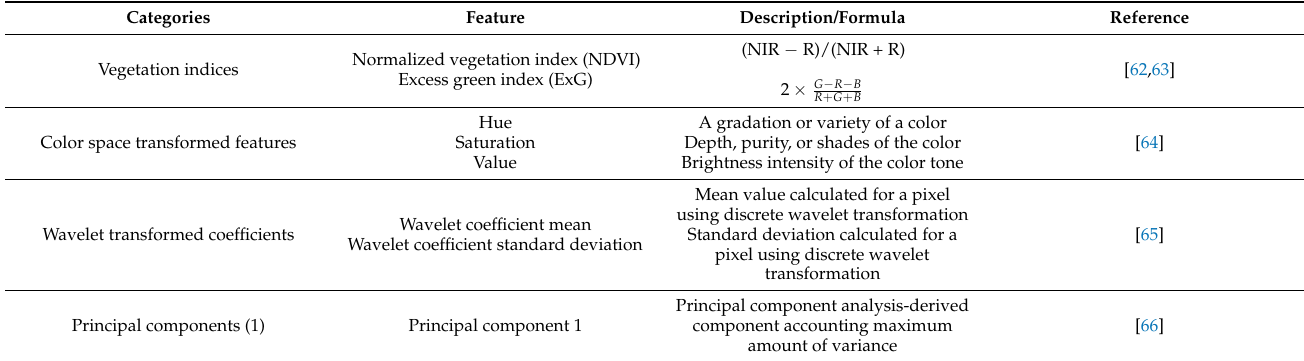
Table 3. An example of features extracted or computed for image